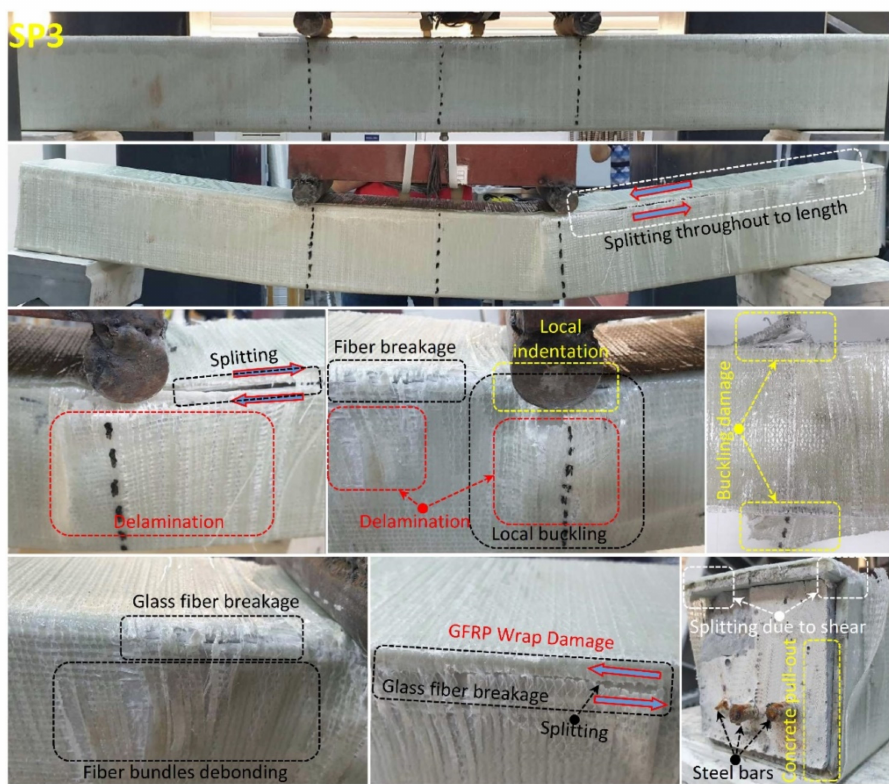
Figure 12. Undamaged and damaged specimen images of SP3.